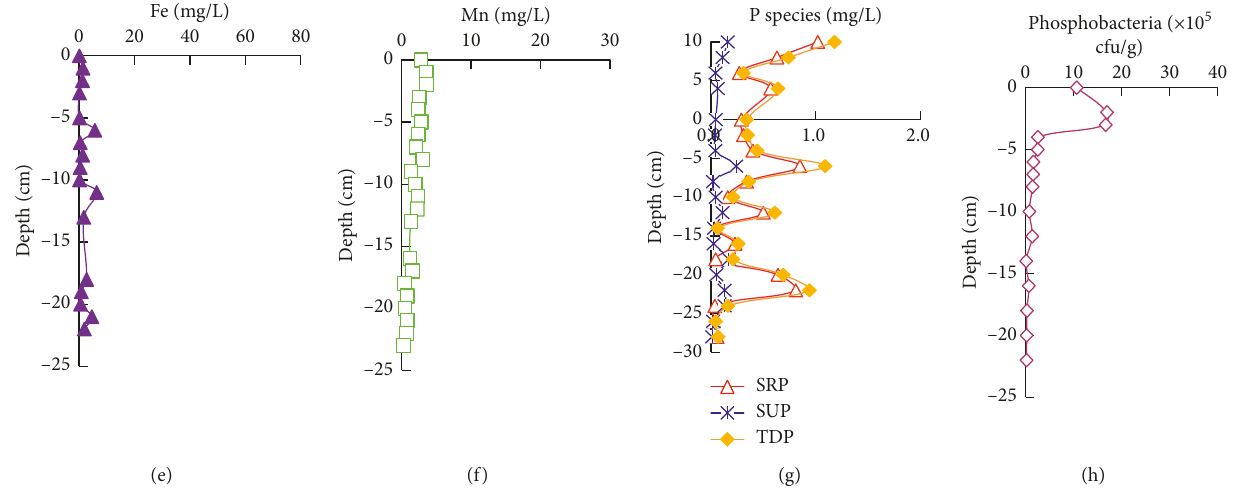
Figure 3: Vertical distributions of dissolved Fe (a), dissolved Mn (b), phosphorus species (c), and phosphobacteria (d) in pore waters at the Jintang site in summer, as well as dissolved Fe (e), dissolved Mn (f), phosphorus species (g), and phosphobacteria (h) in pore waters at the Jintang site in